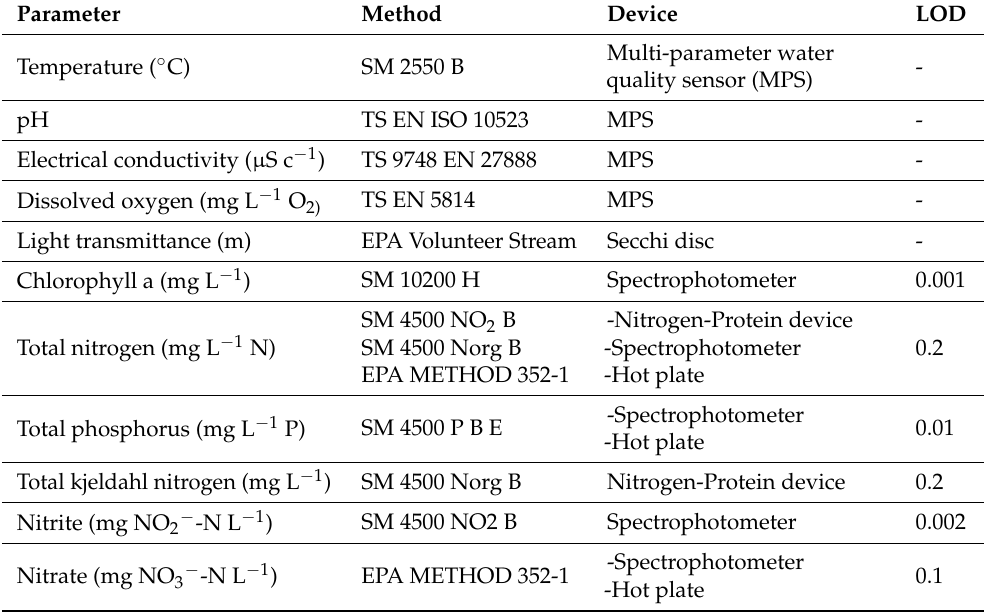
Table 2. Methods used in measuring the environmental parameters (LOD: limit of detection); modi- fied after Altında˘g et al.